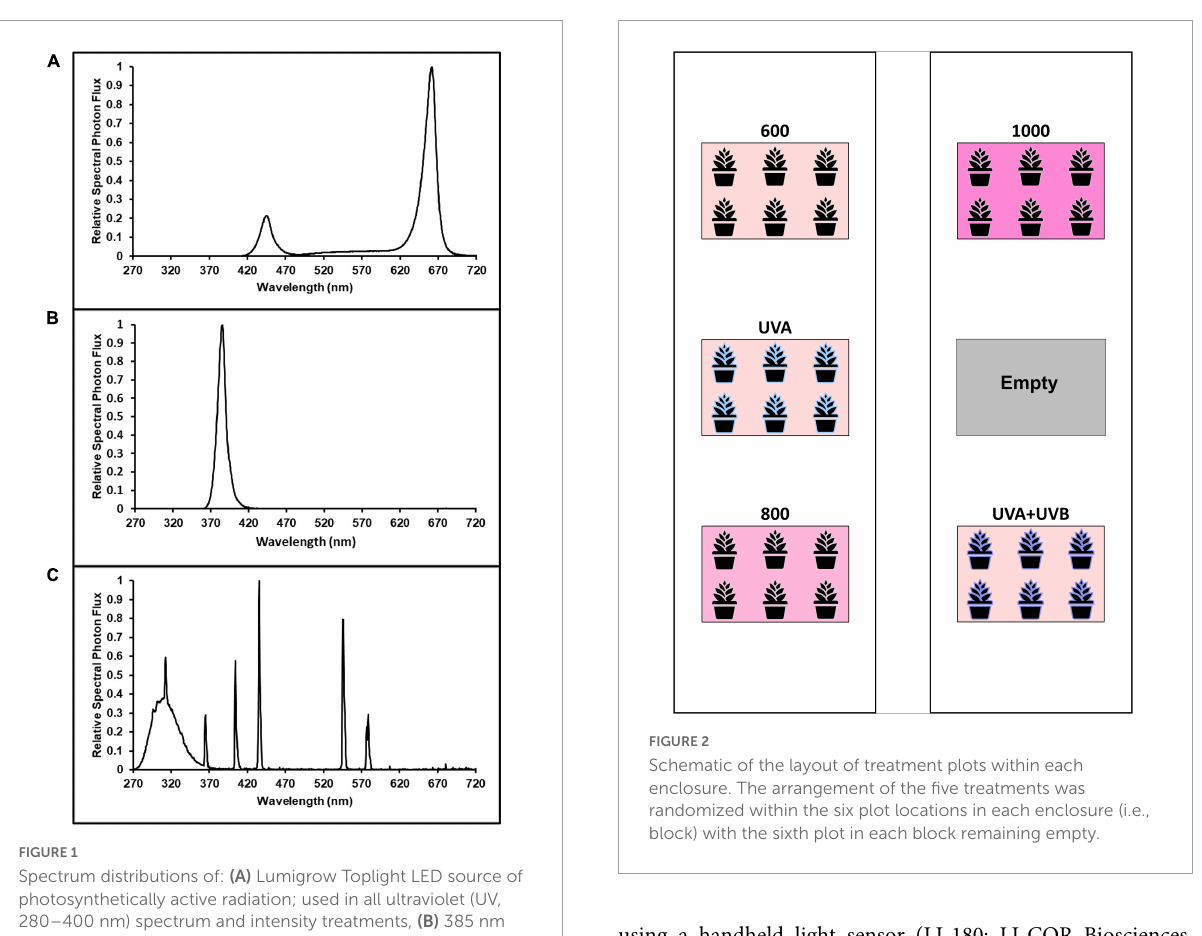
FIGURE1 Spectrum distributions of: (A) Lumigrow Toplight LED source of photosynthetically active radiation; used in all ultraviolet (UV, 280–400 nm) spectrum and intensity treatments, (B) 385 nm peak UVA LEDs; used in UVA treatment (photon flux density of 50 µ mol m − 2 s − 1 ), and (C) broad-band fluorescent UV; used in the UVA + UVB treatment (photon flux density of 3 µ mol m − 2 s − 1 ).